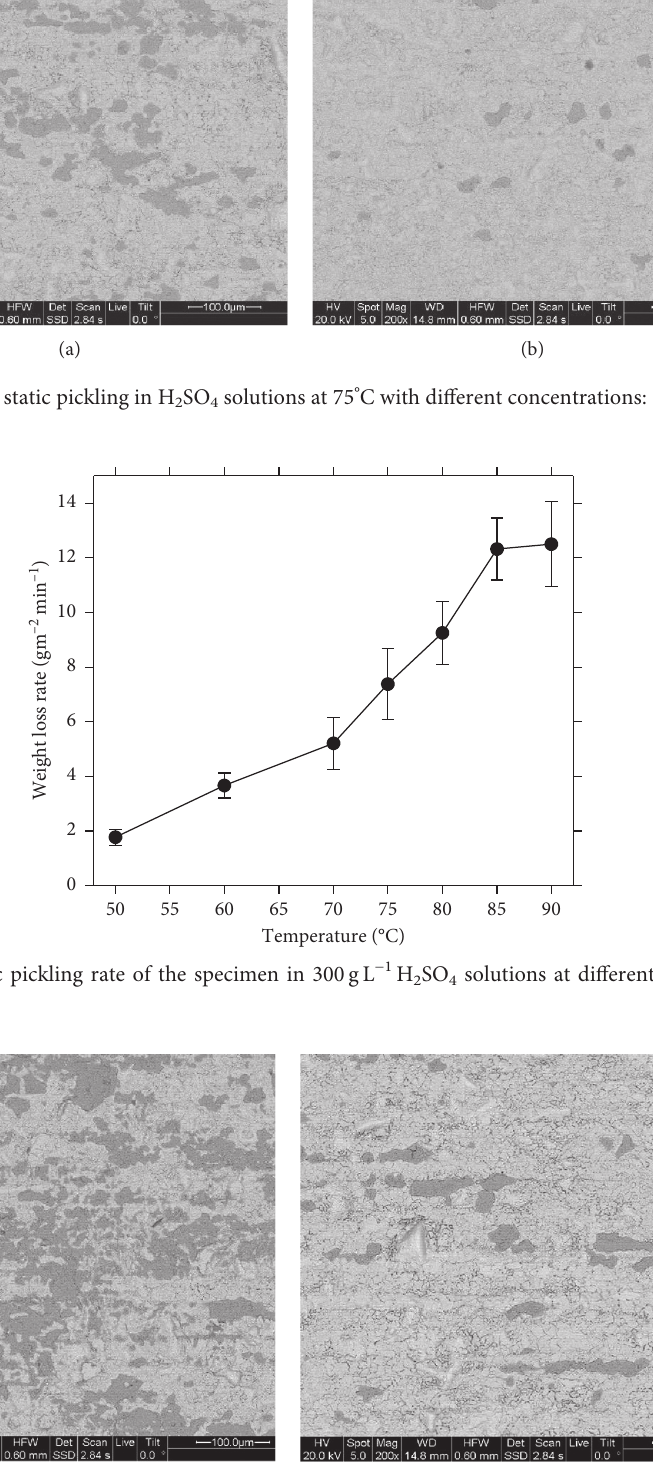
° C (a) and 90 ° C 2 SO 4 solutions at temperatures 60